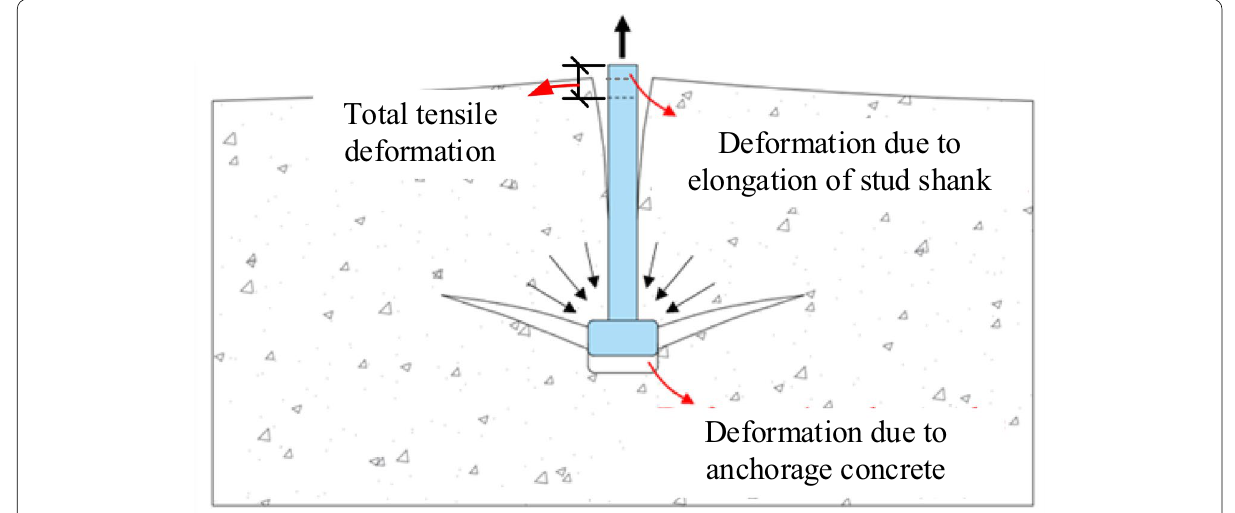
Fig. 5 Deformation components analysis of the headed